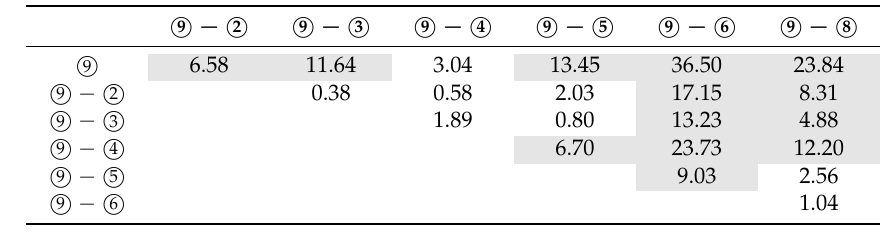
Table 10. The chi-square values of McNemar tests for land cover classification in surface-mined landscapes that involved the exclusion of different types of feature sets from feature subset ( 9 (cid:13)